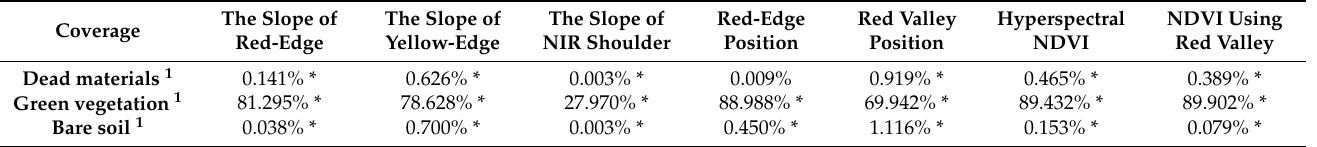
Table 3. Contribution of the coverage of dead materials, green vegetation and bare soil to different spectral